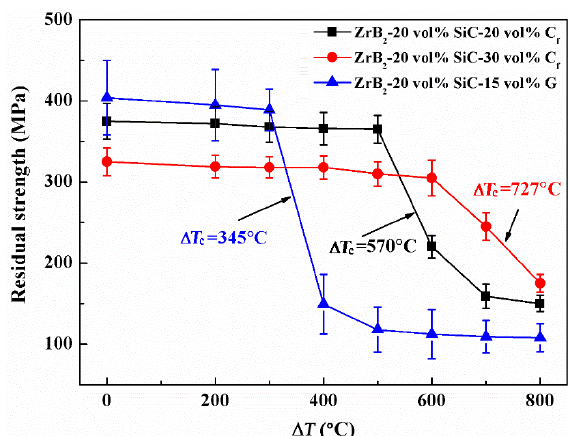
Fig. 8 Residual strength vs. thermal shock temperature difference for ZrB 2 –20 vol% SiC–15 vol% G, ZSC20, and ZSC30, showing a high critical temperature difference (727 ℃ ) for ZSC30.